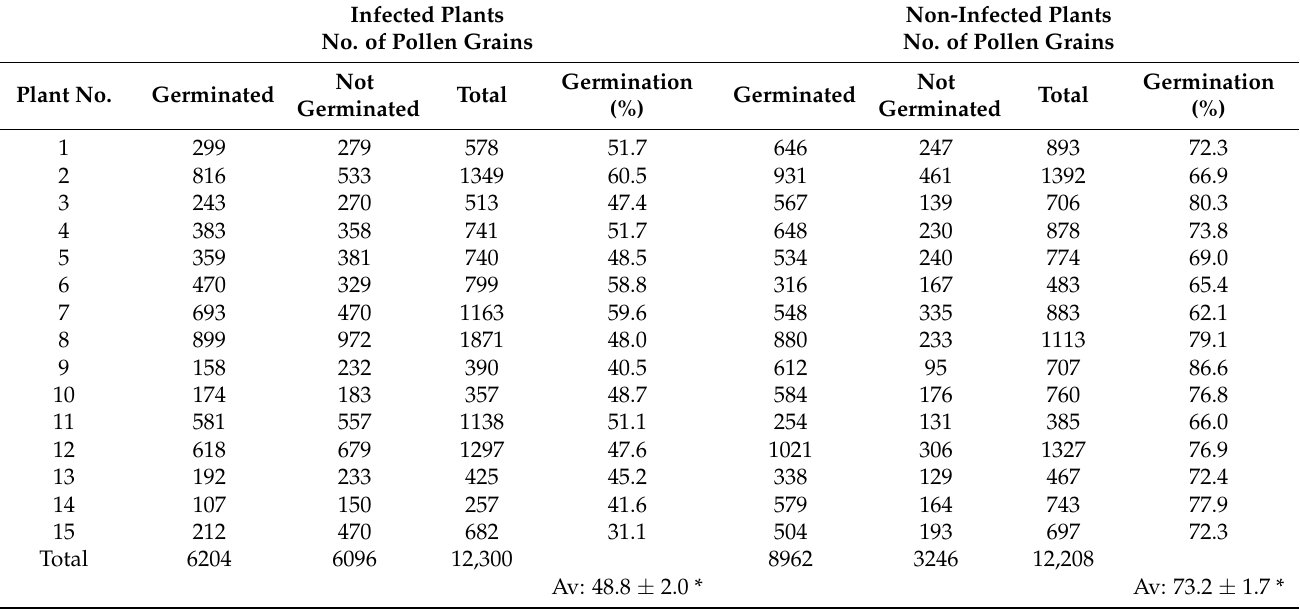
Table 2. ToBRFV’s effect on pollen germination competence.